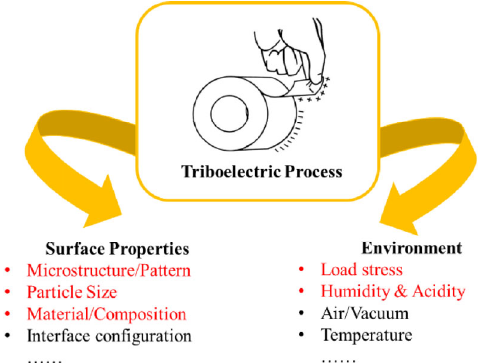
Fig. 9 The schematic illustration of the parameters influencing triboelectric